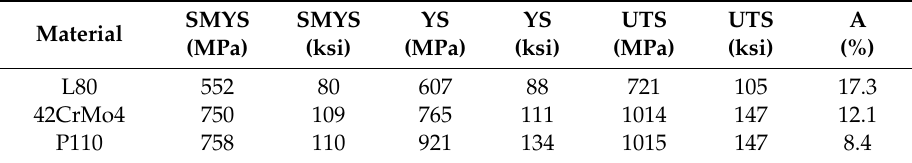
Table 2. Specified minimum yield strength (SMYS), yield strength (YS), ultimate tensile strength (UTS) and fracture elongation (A) of the investigated materials.